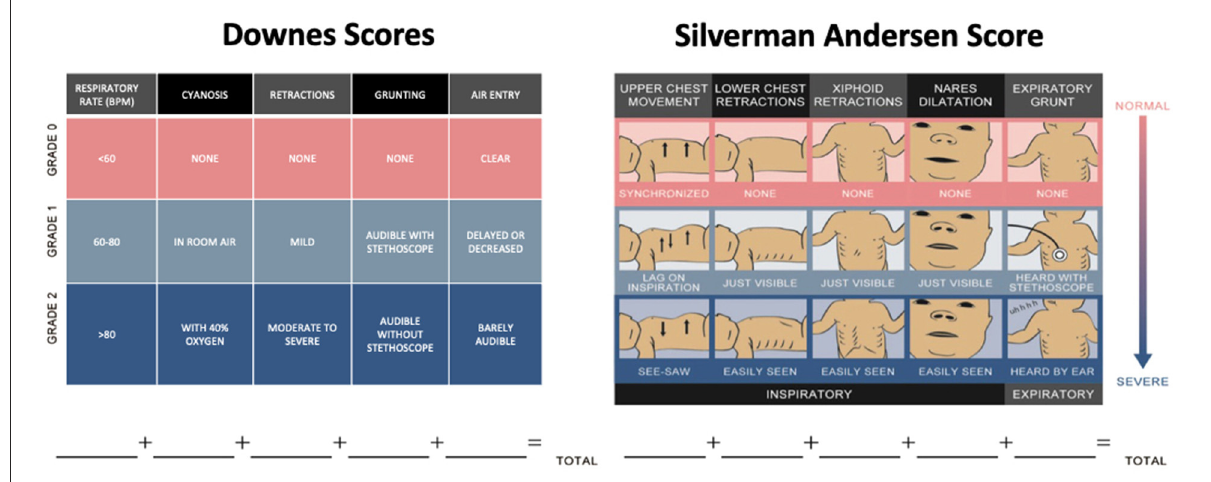
FIGURE2 Scoring systems for respiratory distress syndrome. Downes and Silverman Andersen scores assign 0–2 points for each of five categories of respiratory distress (19, 20). Part of figure reprinted with permission from